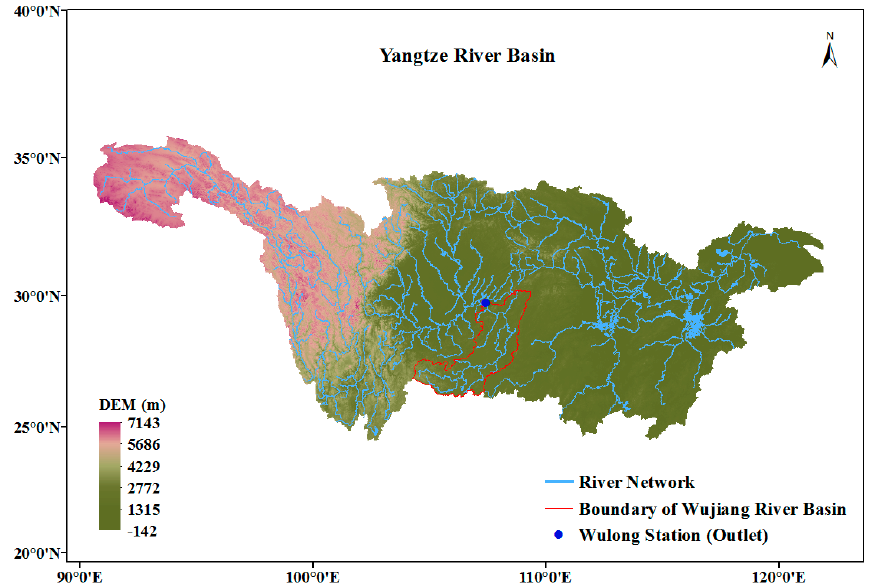
Figure 1. Geographical location of the Yangtze River basin. The upstream sub-basin, the Wujiang catchment, was used to model the hydrological effect of bias-corrected satellite precipitation estimates.